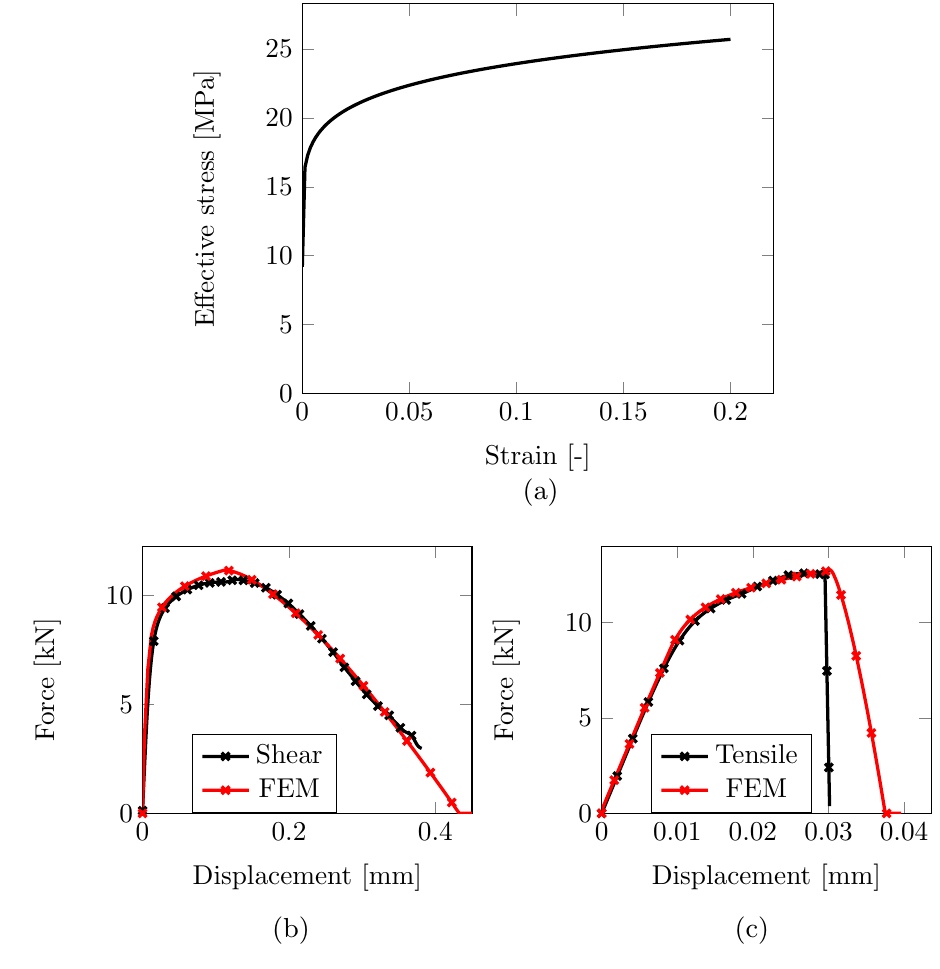
Fig. 13a, it is seen that the force drops as the mesh density is increased. Mesh densities are presented in Fig. 13b–d.